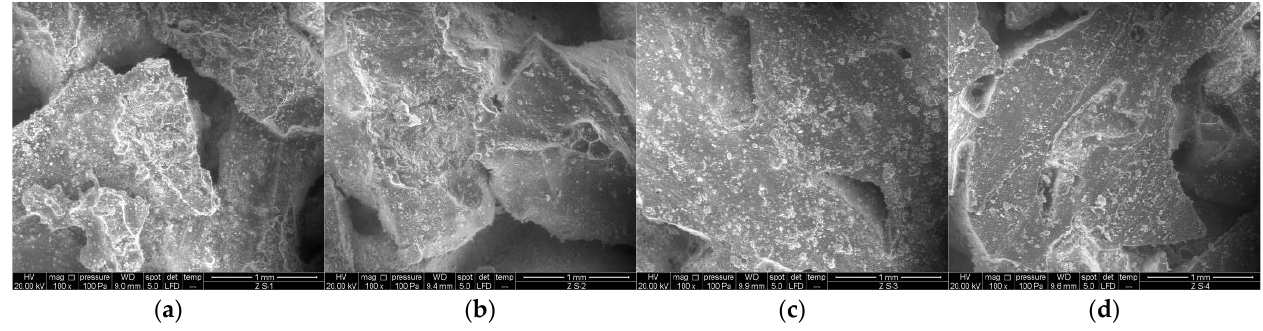
Figure 13. Morphology of a green rubber substrate with an immobilized 2 g of TiO 2 through three horizontal layers (100×); ( a ) surface; ( b ) first layer (2 mm); ( c ) second layer (4 mm); and ( d ) third layer (6 mm).